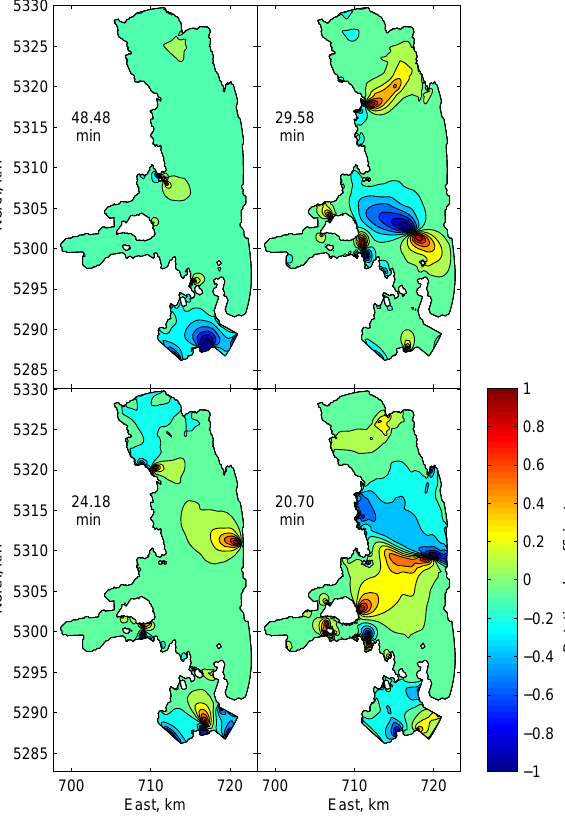
Figure 8. Rotary coefficients for the four free oscillation modes with rotational character. See Fig. S3 in Supplement I for spatial distribution of rotary coefficients for other